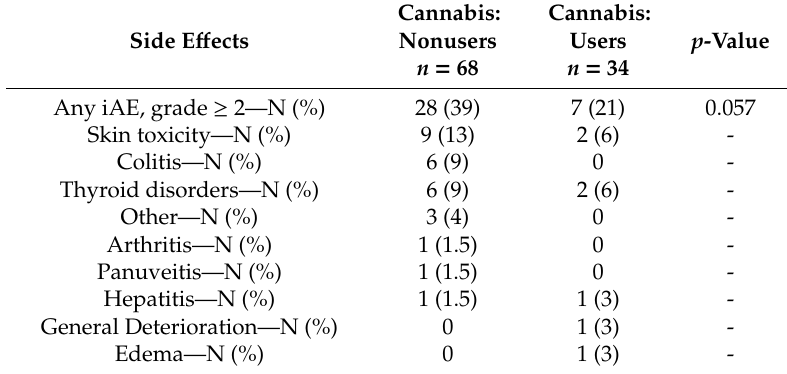
Table 3. Reported immune-related adverse events (iAE), Common Terminology Criteria for Adverse Events (CTCAE) grade ≥